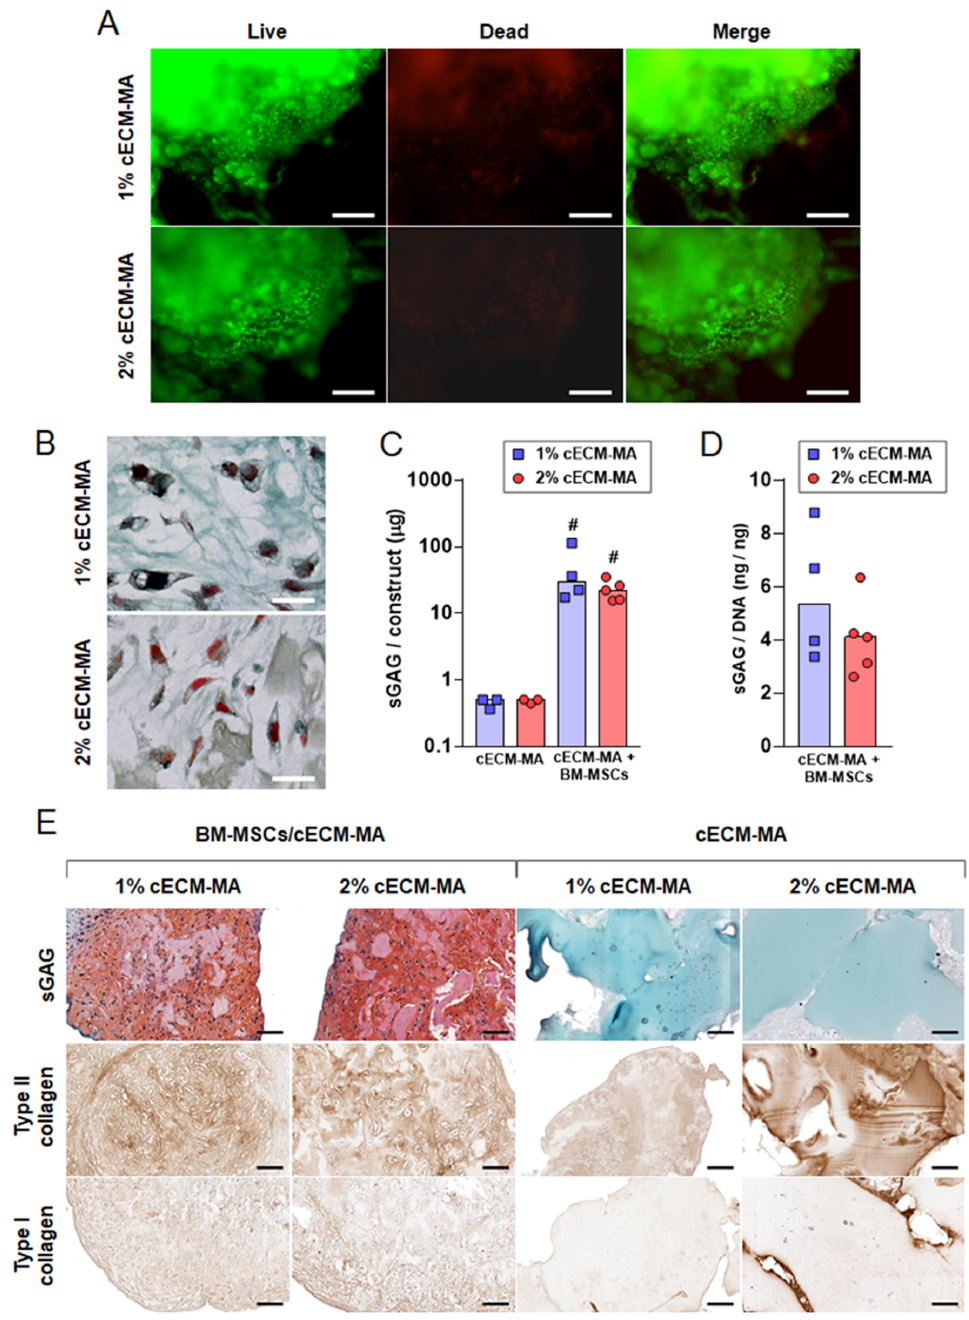
Figure 6. Biocompatibility and chondrogenic inductivity of cECM-MA. BM-MSCs were encapsu- lated in gels containing 1 or 2% cECM-MA and cultured in chondrogenic medium for 21 days in hypoxia. ( A ) Cell viability 7 days following encapsulation in cECM-MA. Living cells are stained in green, and dead cells are stained in red (scale bars = 200 µm). Histological ( B , E ) and biochemical ( C , D ) characterisations of tissue constructs after 21 days of in vitro culture. ( B ) Goldner’s Masson trichrome staining of cells encapsulated in cECM-MA (scale bars = 20 µm). ( C ) Quantification of the sGAG content of acellular gels or gels seeded with BM-MSCs. ( D ) sGAG content of cell-seeded gels normalised to DNA content. The values given in the dot plots represent individual scaffolds as data points with the median as bar; # indicates statistical significance compared to acellular gels ( p < 0.05). ( E ) Representative pictures of parallel sections of constructs stained for type I and II collagens and sGAGs as indicated (scale bars = 100 µ